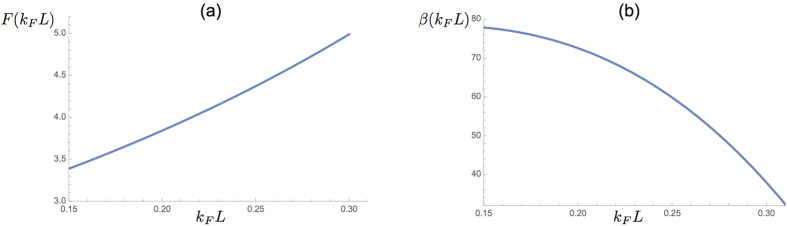
The dependence of F and β on kFL.